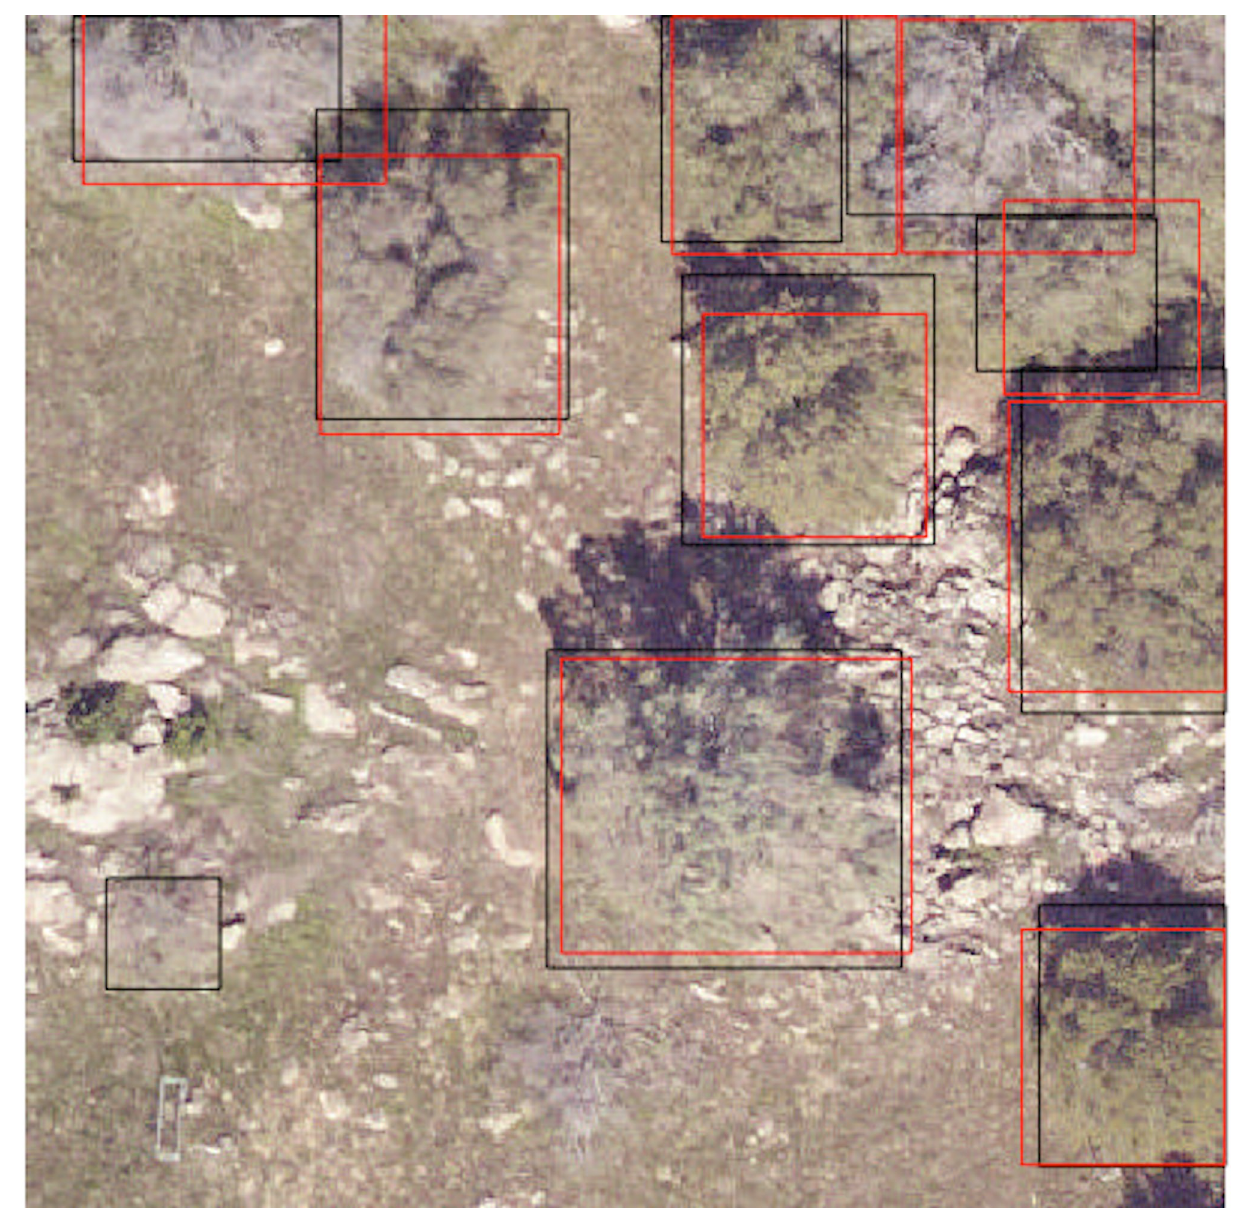
Fig 6. Example evaluation from the NeonTreeEvaluation R package. Predicted boxes (see below) in red and ground truth boxes are in black. In this image there are 10 image-annotated boxes, and 9 predictions. Each prediction matches an image-annotated box with an intersection-over-union score of greater than 0.4. This leads to a recall score of 0.9 and a precision score of